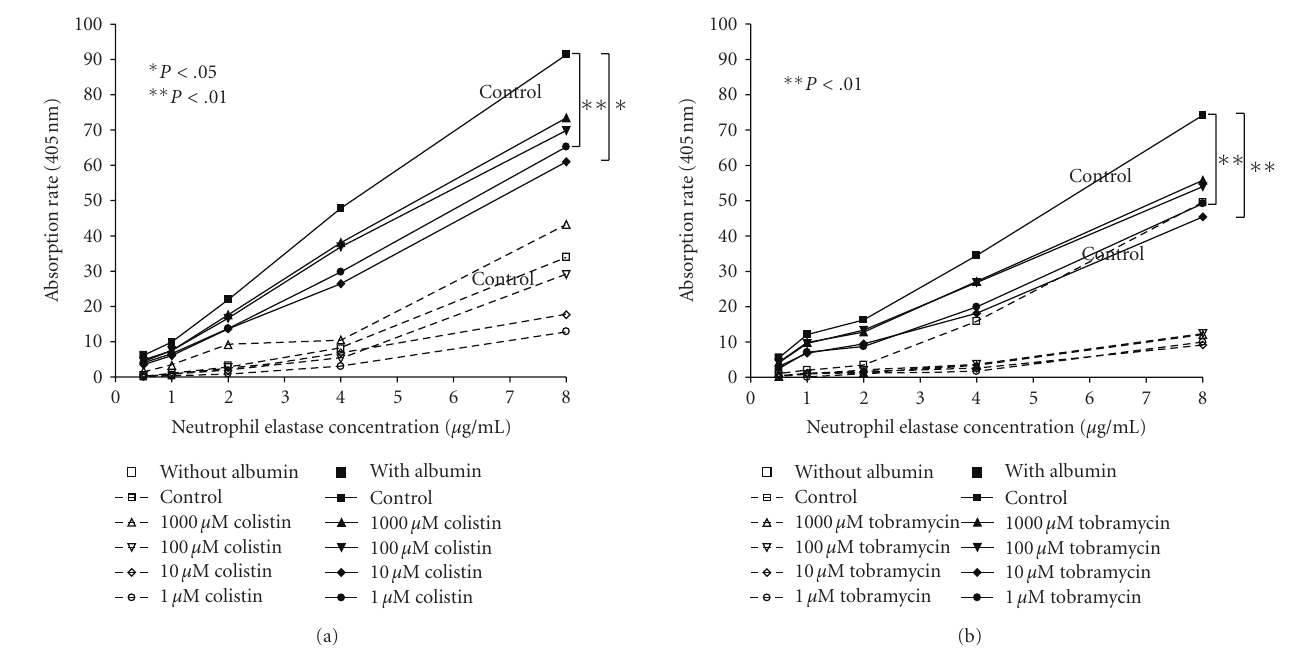
Figure 1: E ff ects of colistin (a) and tobramycin (b) on neutrophil elastase measurement (absorption) are given for di ff erent concentrations of colistin and tobramycin (1, 10, 100, 1000 μ M) either in presence (filled symbols, continuous lines) or in absence (blank symbols, dashed lines) of albumin. Data are presented as means of n = 3. ∗ P < .05; ∗∗ P < .01 compared to